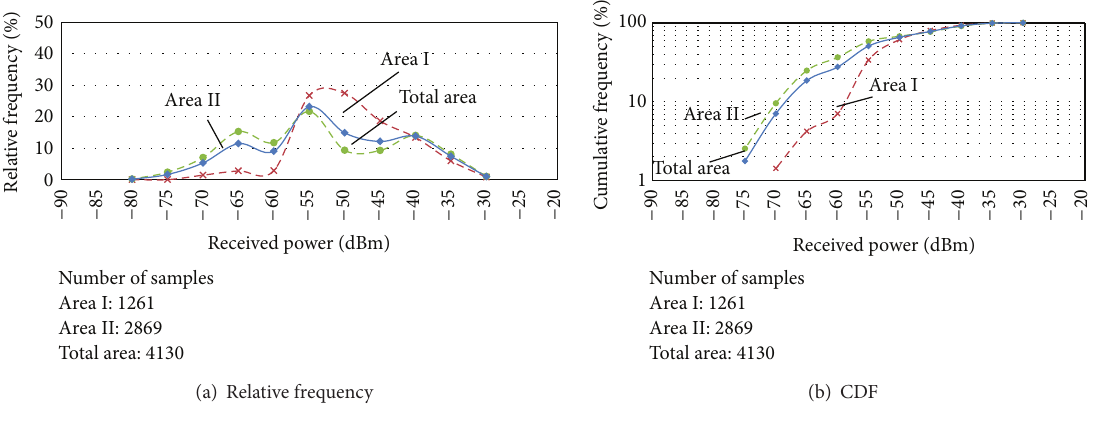
Figure 8: Measured received power distribution.